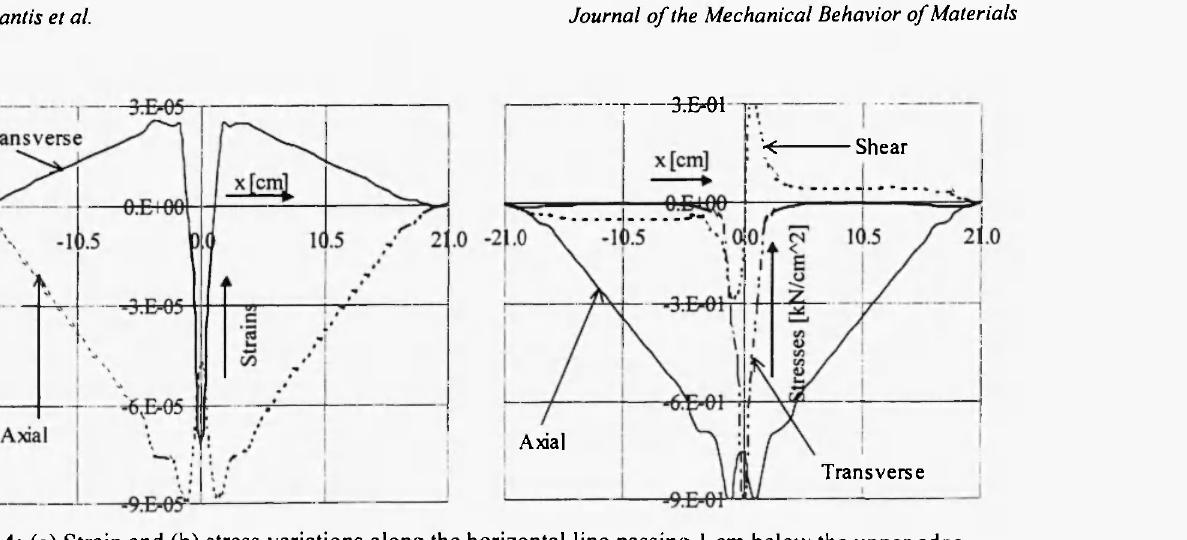
Fig. 4: (a) Strain and (b)